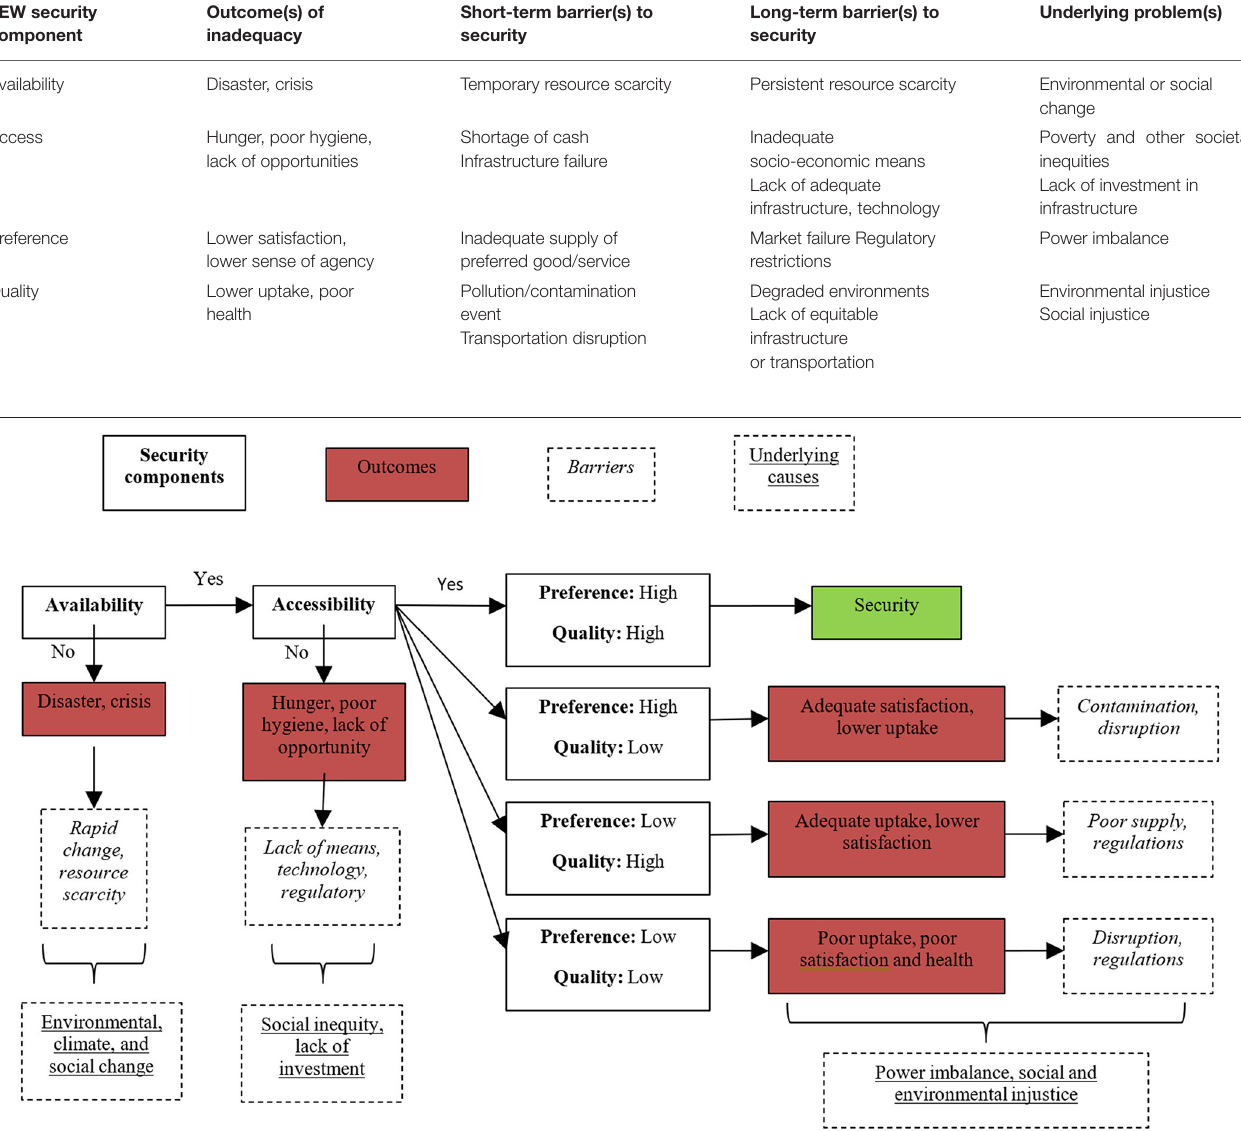
TABLE 1 | Components, outcomes, barriers, and causes of FEW security.